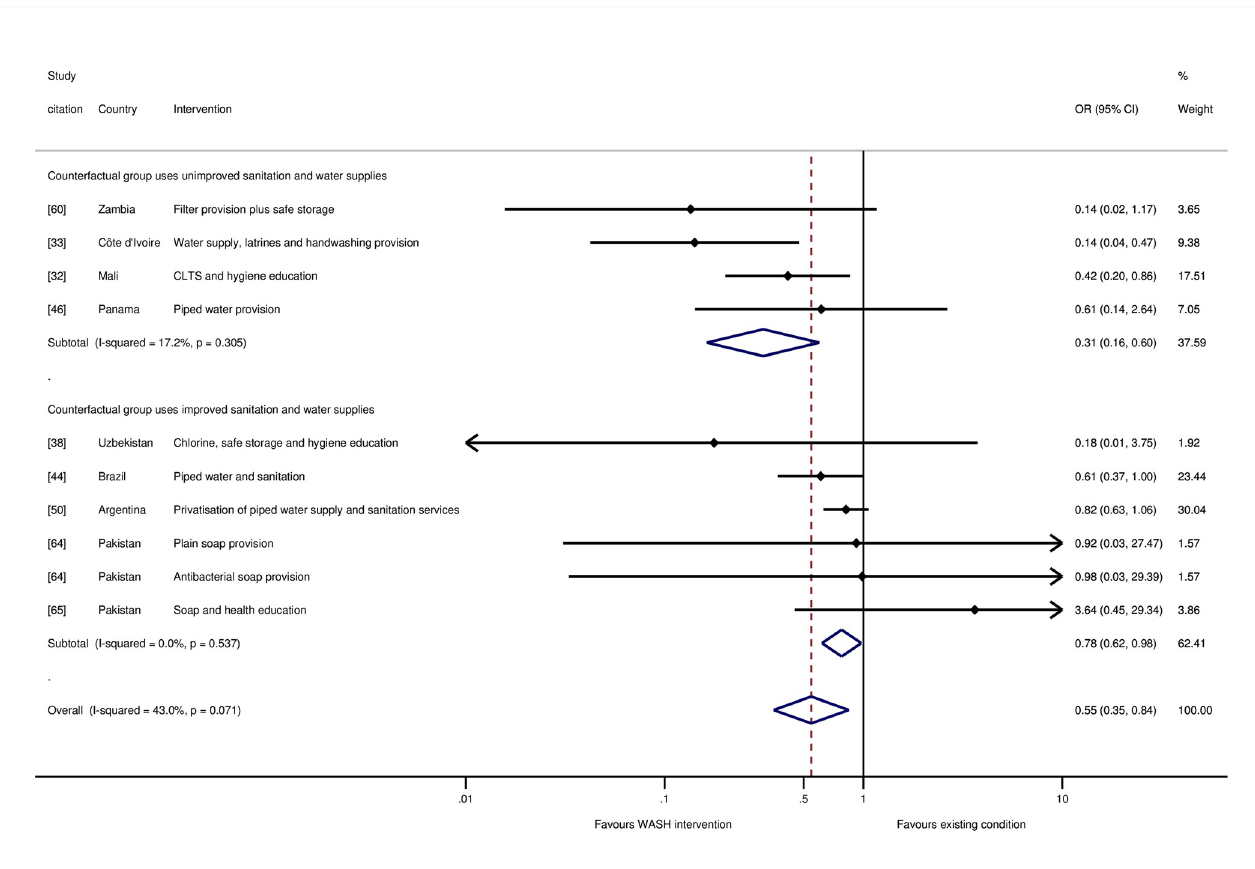
Fig 9. Effects on diarrhoea mortality in childhood of WASH